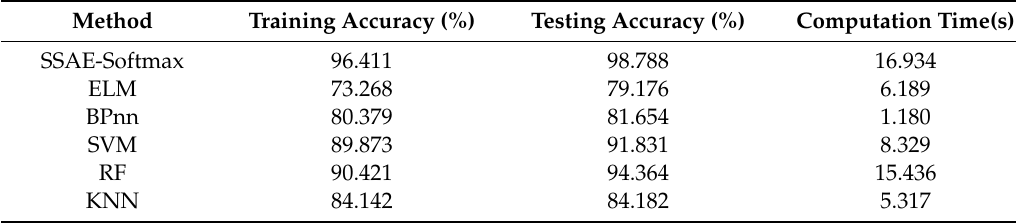
Figure 11. The accuracy of the six methods. Table 3. Description of the compression average accuracy.